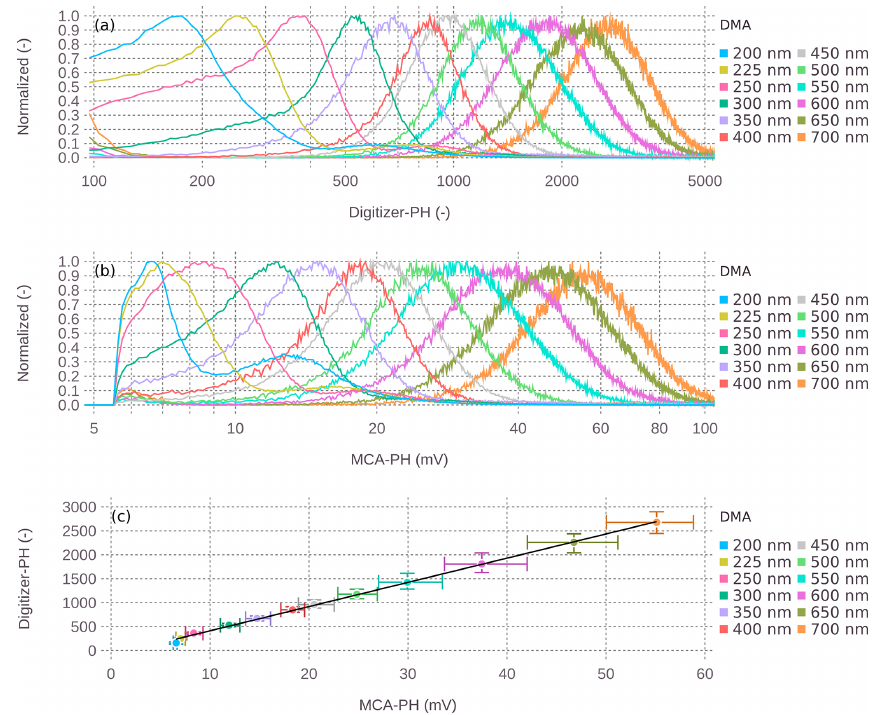
Figure 5. (a) Digitizer-PH and (b) MCA-PH histograms for dry size-selected ammonium sulfate particles between 200 and 700nm. The his- tograms were normalized such that the largest value equals unity. (c) Comparison of digitizer-PH and MCA-PH at the peak of the histogram. Error bars correspond to the 95% confidence interval of the mode determined via a curve fit of the data to a lognormal distribution. The line corresponds to linear regression with the equation digitizer-PH = MCA-PH ∗